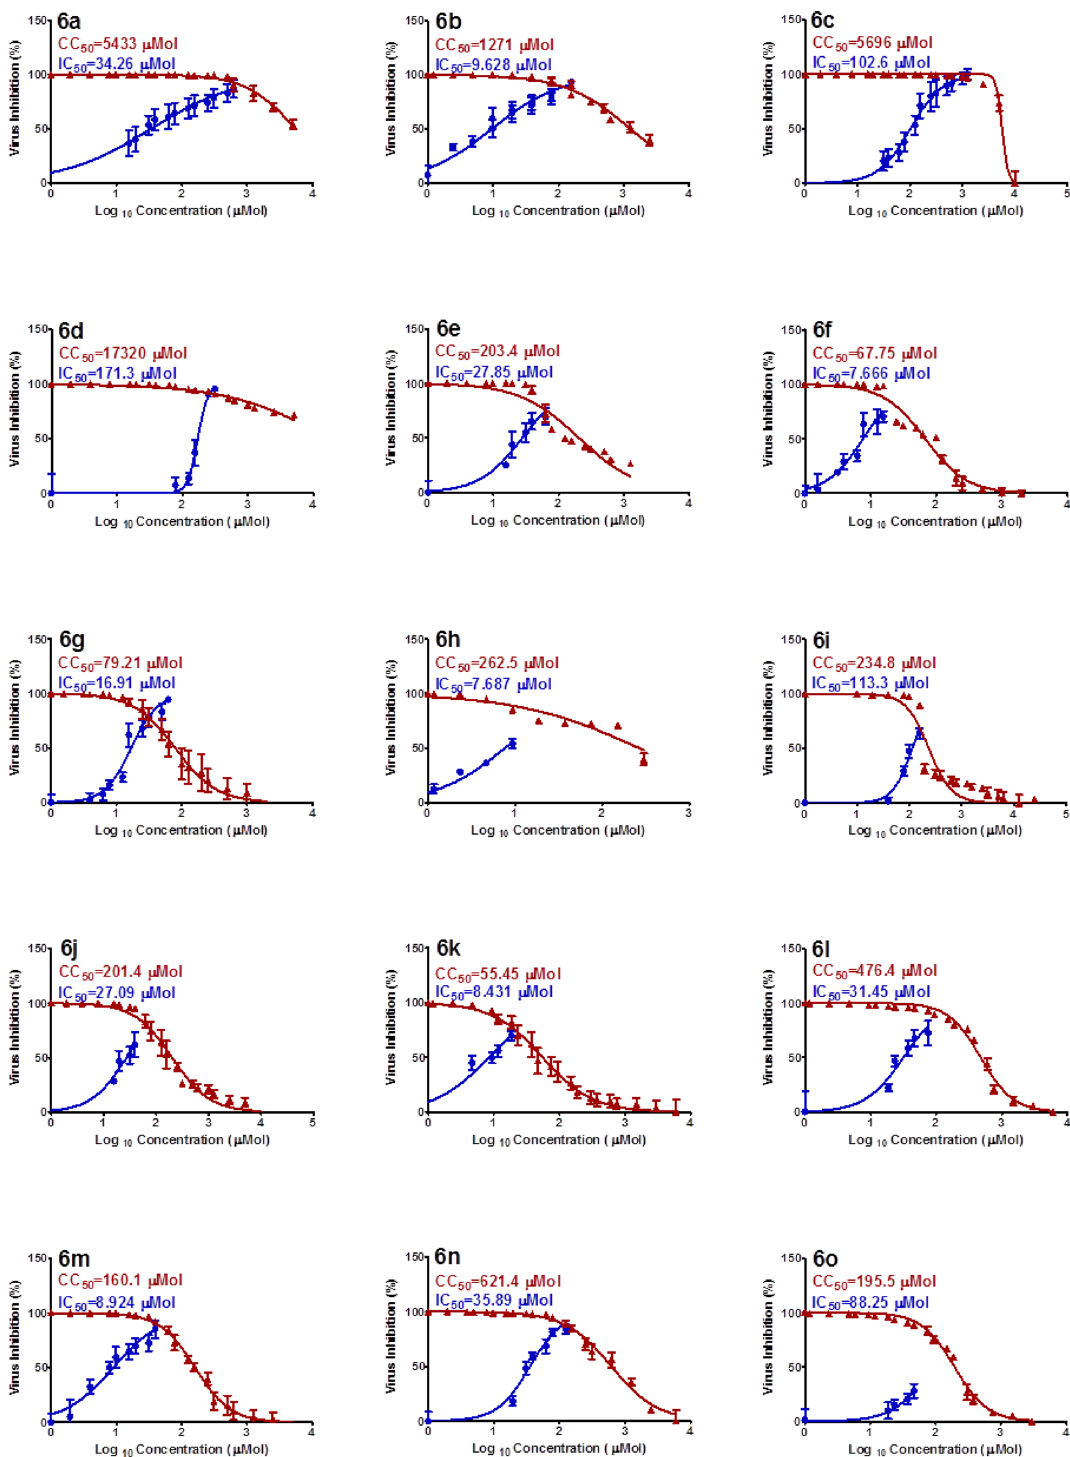
Figure 9. Dose–response curves for the synthesized agents against